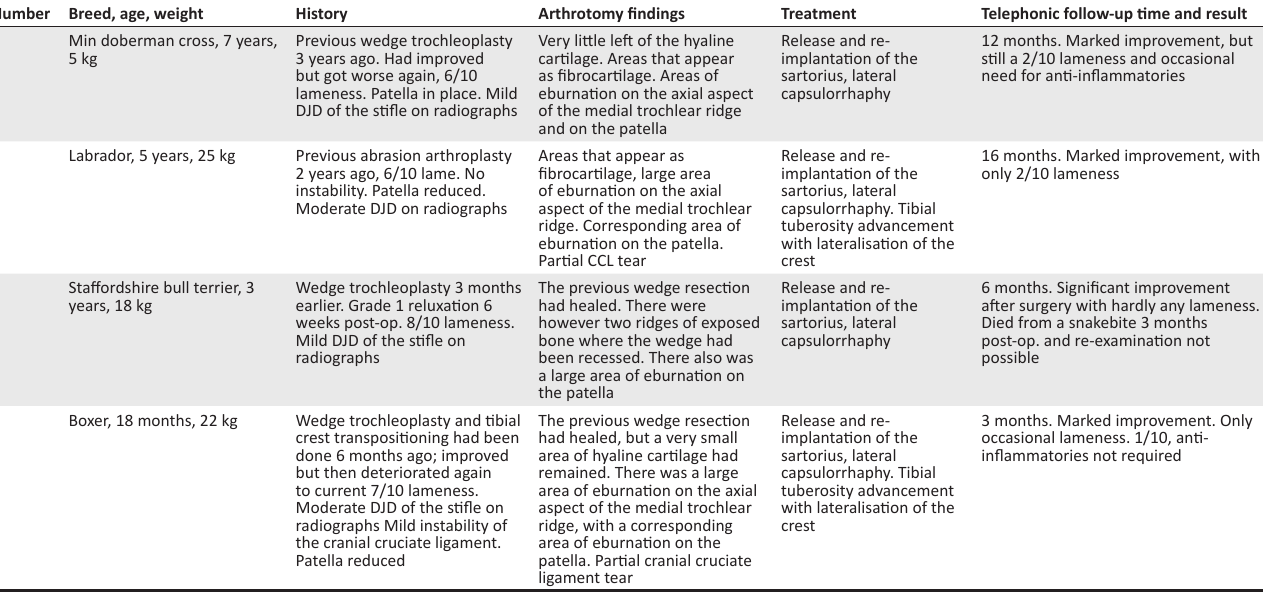
FIGURE 1: (a, b) Photographs of the stifles of the dog that was euthanased. TABLE 1: Signalment, findings during arthrotomy, treatment and follow-up of the four clinical cases. Number Breed, age,